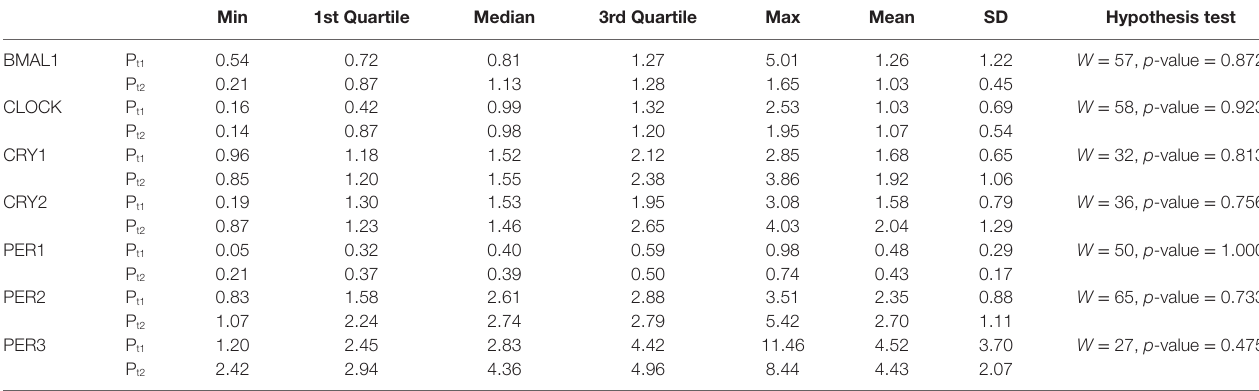
TaBle 3 | Characterization of the gene expression within the patient group between the values recorded at t1 (P t1 ) and the ones recorded at t2 (P t2 ), as well as the results of hypothesis tests for comparison of gene expression between these time-points. Min 1st Quartile Median 3rd Quartile sD hypothesis test BMAL1 P t1 W = 58, p -value = 0.923 P